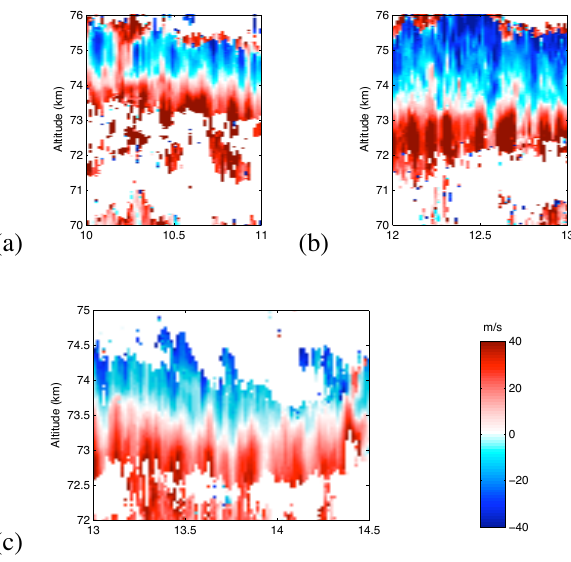
Fig. 17. Segments of meridional wind maps for May 27, 2003, (a and b) and May 28 (c).